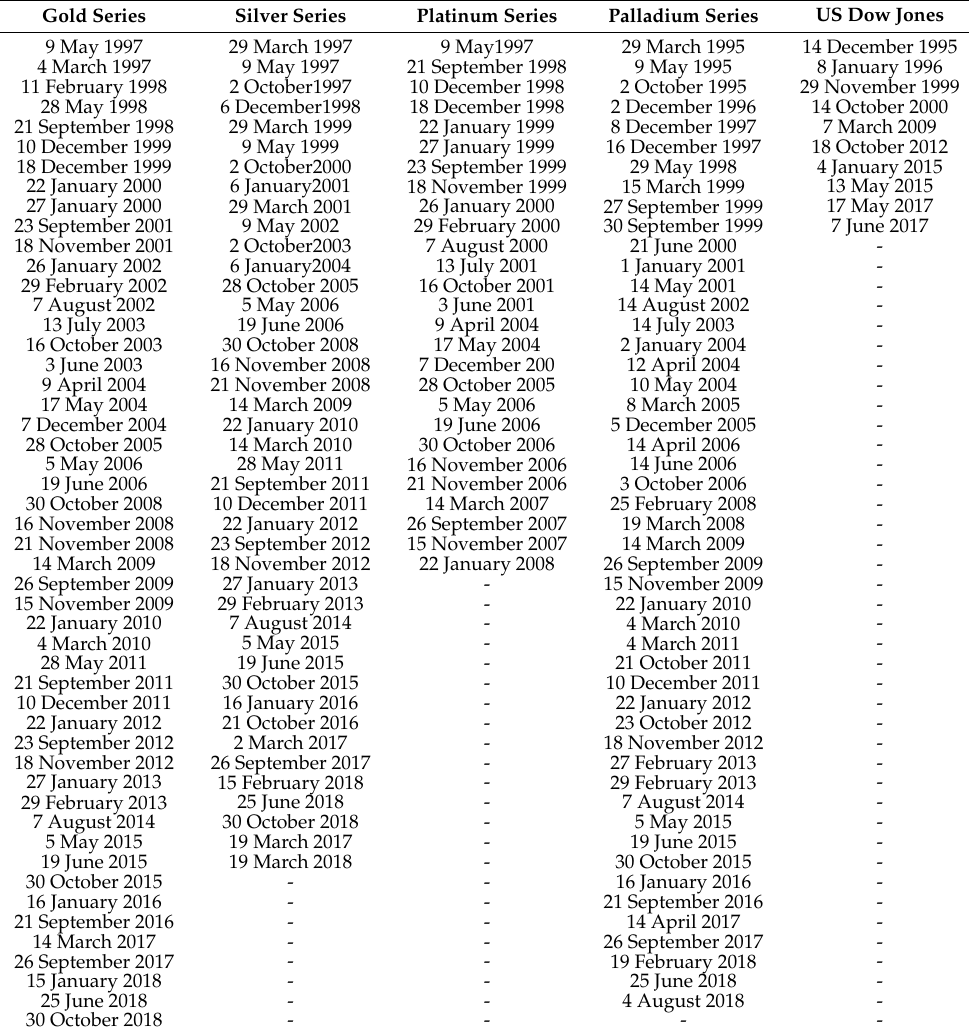
Table A4. Precious Metal Prices and the US Dow Jones Break